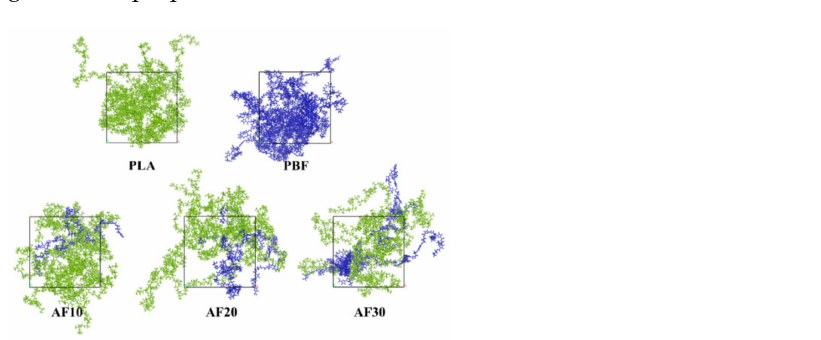
Figure 4. Models of pure PLA, pure PBF, and three blends. The green chain is the PLA molecular chain in the system, and the blue chain is the PBF molecular chain in the